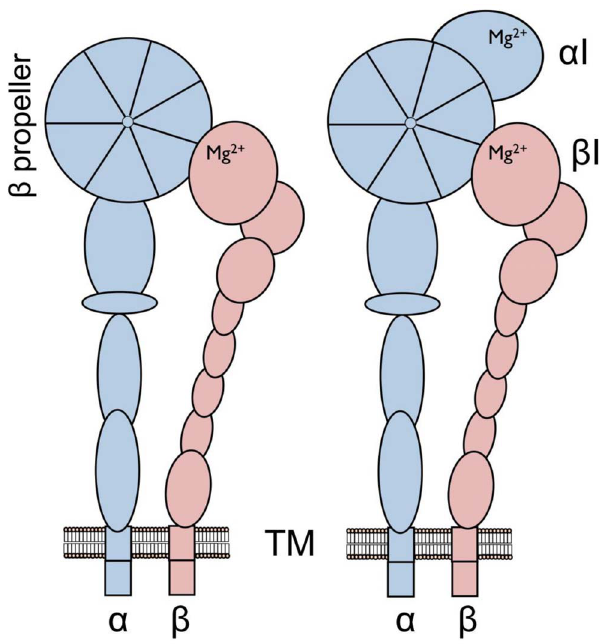
Figure 1. Schematic representation of integrin heterodimers. Integrins are large heterodimeric, bi-directionally signaling, cell surface receptors that consist of a large extracellular ectodomain, a transmem- brane region and relatively short intracellular ‘‘tails’’ (right). (A) The constituent a and b subunits are non-covalently associated and the a subunit (ca. 1100 residues) is generally larger than the b subunit (ca. 800 residues). (B) Half of the human integrin a subunits – a 1, a 2, a 10 and a 11 of the collagen receptors and a D, a X, a L, a M and a E of the leukocyte clade – contain an additional domain known as the ‘‘inserted’’ a I domain, which buds out between the second and third repeat of the b -propeller domain located at the a subunit N-terminus. The a I domain is a member of the von Willebrand factor A domain family present in many other proteins, including all integrin b subunits and many proteins related to the extracellular matrix, and it is known to adapt the Rossmann fold. The a I domain contains the highly solvent-exposed MIDAS site (Mg 2 + ) where natural ligands bind via a negatively-charged amino acid glutamate. The b I-like domain is located towards the N- terminus in b subunits and acts as the recognition site for external ligands in those integrin heterodimers that do not have the a I domain (A), but binds a glutamate residue – an intrinsic ligand – from the a I domain in the collagen receptor and leukocyte clade a subunits (B).